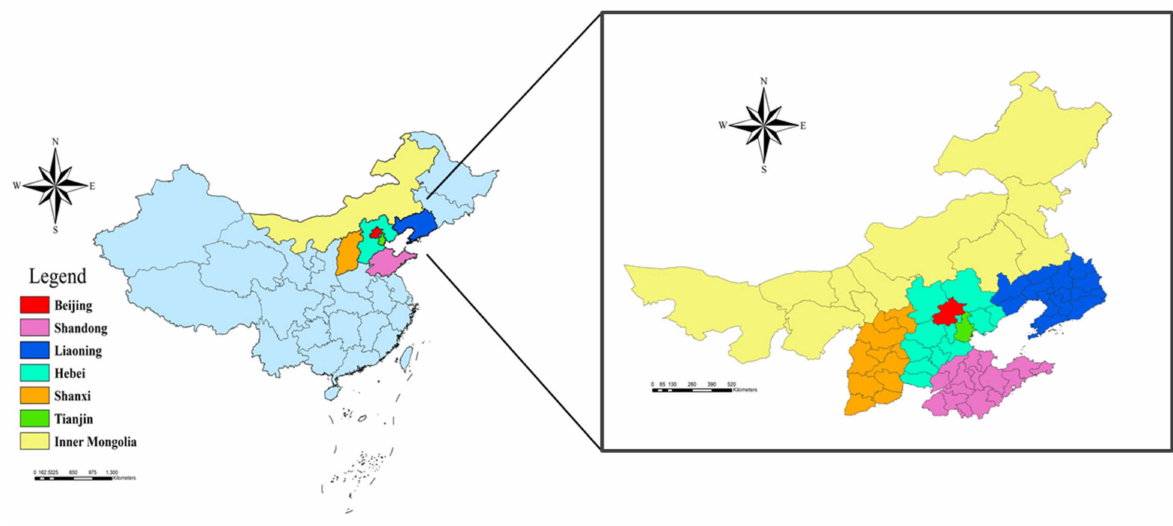
Figure 1. The geographical location of the study